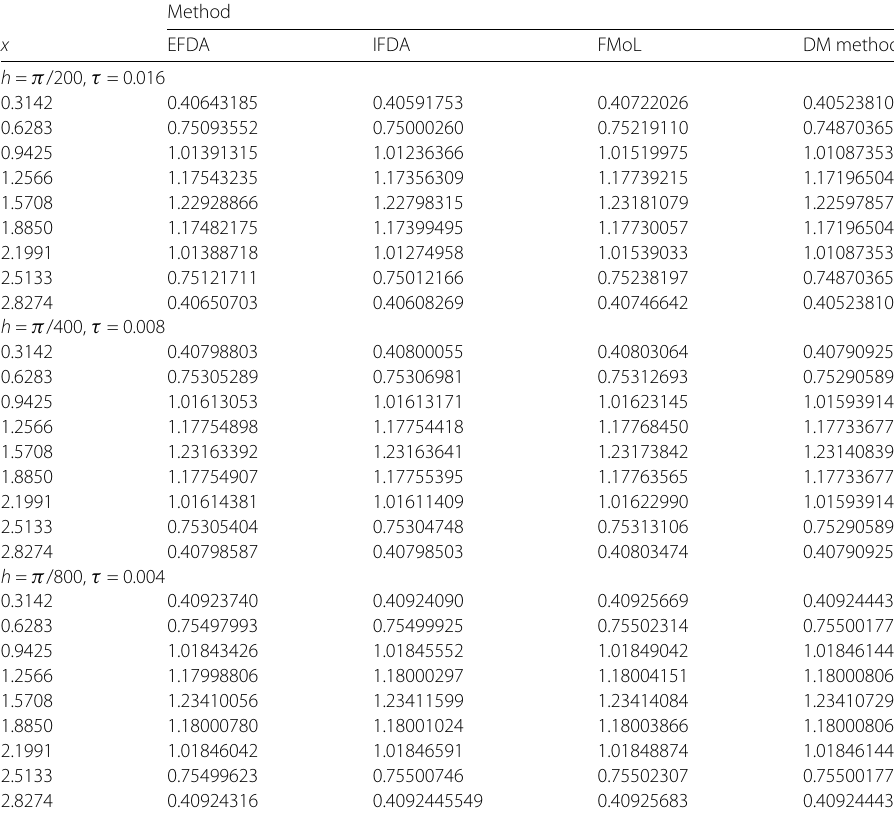
Table 1 Values of the approximate solution of problem (57) at different values of x and T = 0.3, using Ω = (0, π ), α = 1.8, and K = 0.1. Computationally, we used different combinations of values of h and τ . The results were obtained using the EFDA, IFDA, and FMoL reported in [36], as well as the DM method introduced in the present manuscript Method x EFDA IFDA FMoL DM method h = π /200, τ = 0.016